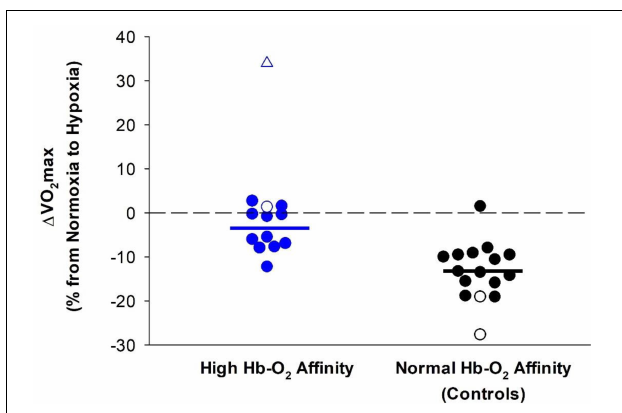
FIGURE 3 | Difference in ˙VO 2max between normoxia and hypoxia in humans with high Hb-O 2 affinity (blue symbols) (–4 ± 5% without outlier) compared to normal Hb-O 2 affinity controls (black symbols) (–13 ± 6%). Open symbols represent data from Hebbel et al. (1978). The open triangle represents an outlier not included in the calculation of the mean. Closed symbols represent data from Dominelli et al. (2020). Solid bars represent the average change in ˙VO 2max in both groups not including the outlier with high Hb-O 2 affinity. The dashed line provides a reference for no